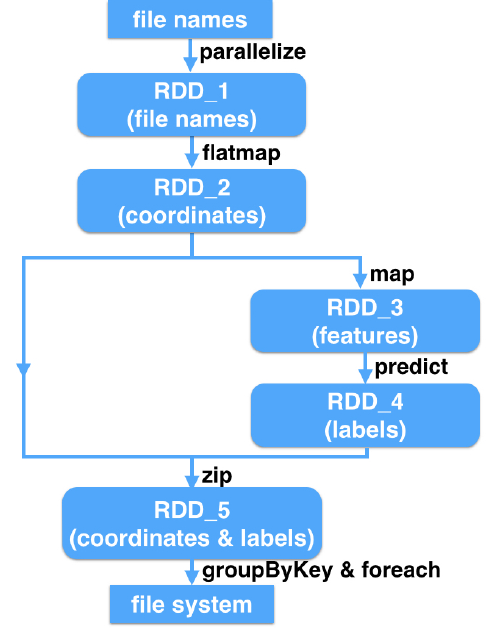
Figure 1: The directed acyclic graph (DAG) in our implementa- tion using Apache